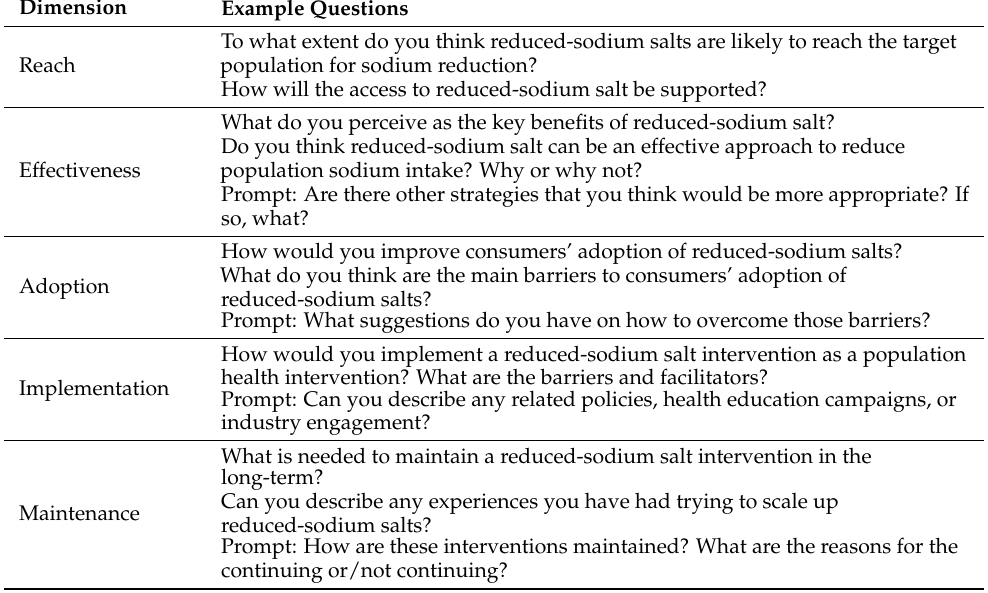
Table 1. The reach, effectiveness, adoption, implementation, and maintenance (RE-AIM) framework (RE-AIM) dimensions and qualitative data example